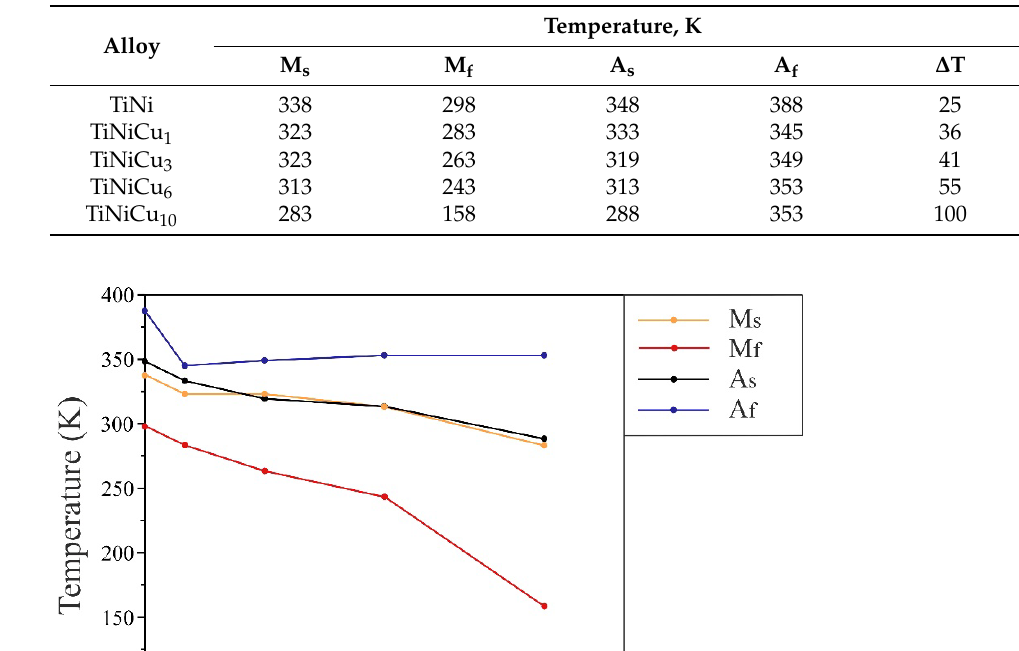
Table 2. Characteristic temperatures of MTs for porous alloys.